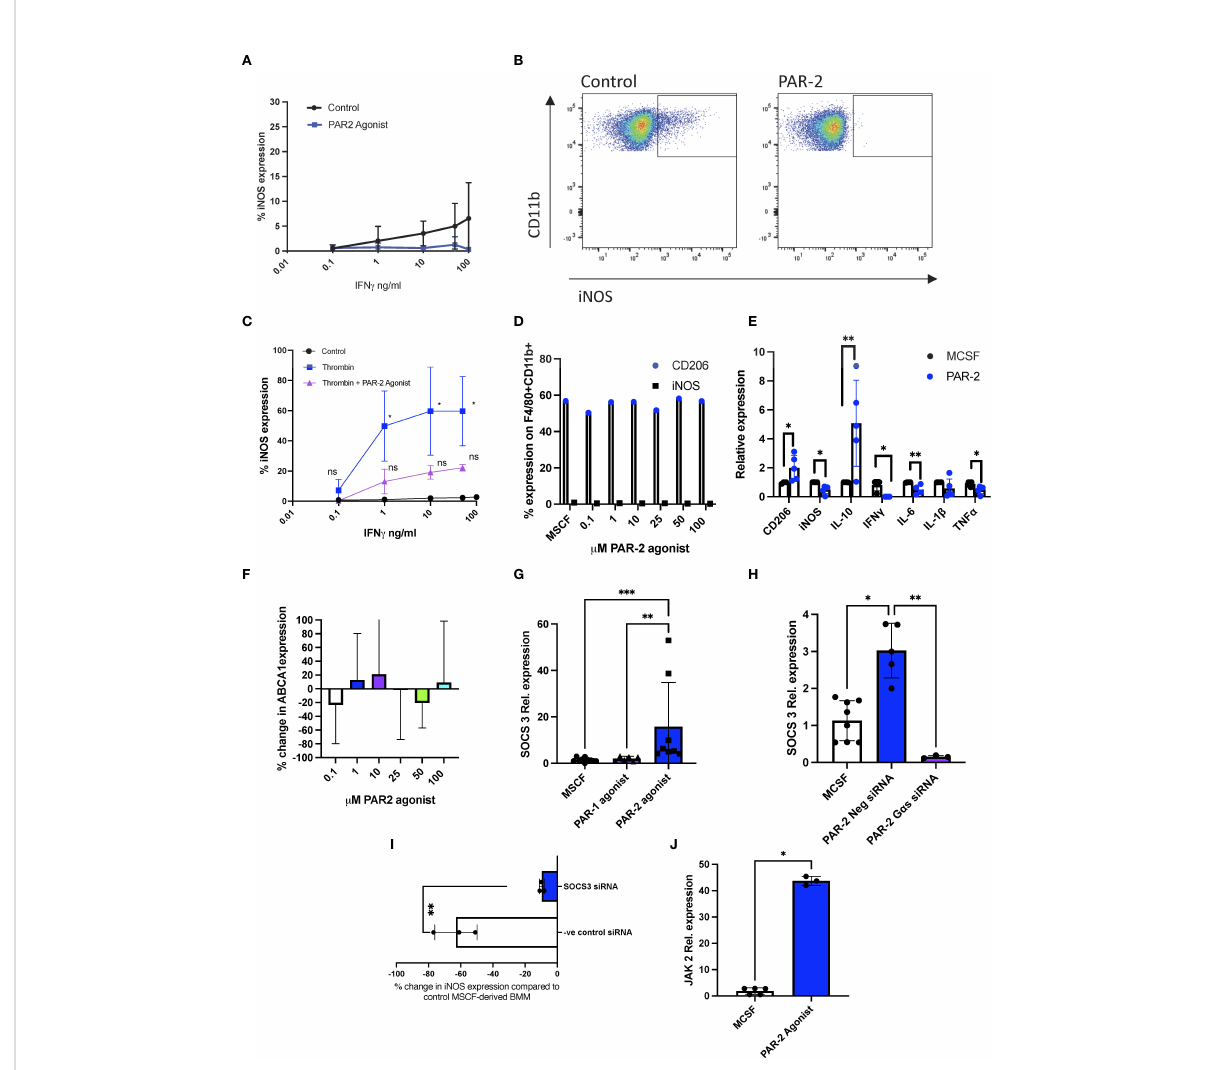
FIGURE 1 PAR-2 signalling reduces sensitivity to IFN g by enhancing SOCS3 expression. (A). MCSF-derived BMM cultured for 3 hours with 100 µM PAR-2 agonist or maintained in MCSF (control) prior to the addition of escalating concentrations of IFN g . Cells were then analysed by intracellular fl ow cytometry for iNOS expression. Data shows results from 3 (PAR-2) and 5 (control) separate groups of experiments. (B). Representative fl ow cytometry pro fi les of experiment described in Fig1A. (C). MCSF-derived BMM incubated with increasing concentrations of IFN g (control), or primed beforehand with thrombin for 24 hours (Thrombin) or with thrombin and 100 µM PAR-2 agonist prior to IFN g stimulation. Cells were then analysed by intracellular fl ow cytometry for iNOS expression. Data shows results from 3 experiments. The signi fi cance levels shown are in comparison to MCSF control at the same concentration of IFN. (D). CD206 (white bars) or iNOS (black bars) expression on F480+CD11b+ cells analysed by intracellular fl ow cytometry after 24 hours culture with increasing concentrations of PAR2 agonist. (E). qPCR data of MCSF-derived BMM treated for 24 hours with 100 m M PAR-2 agonist (n=5) or maintained in MCSF (control) (n=4). (F). ABCA1 expression in MCSF-derived BMM incubated for 24 hours with escalating concentrations of PAR-2 agonist before analysis by fl ow cytometry. Data represents percentage change from control (MCSF) expression. Data from at least 3 separate experiments. (G, H). Relative SOCS3 expression by qPCR analysis of MCSF-derived BMM. In F, cells maintained in MCSF (n=10) for 24 hours (circle), or after 24 hours incubation with 100 m M PAR-1 agonist (TFLLR-NH2) (n=6) (Triangle) or 100 m M PAR-2 agonist (n=8) (Square). In H, cells maintained in MCSF for 24 hours (n=8) (white bar), or after 24 hours incubation with 100 m M PAR-2 agonist +/- pre incubation for 24 hours with either 30pmol control siRNA (n=4) (blue bar) or 30pmol siRNA speci fi c for G a s (n=3) (purple bar). (I). MCSF-derived BMM incubated for 24 hours with 30pmol siRNA to SOCS3 (white bar) (n=3) or negative control siRNA (blue bar) (n=3), before a 3-hour incubation with 100µM PAR-2 agonist followed by 24-hour incubation with IFN g (1ng/ml). iNOS